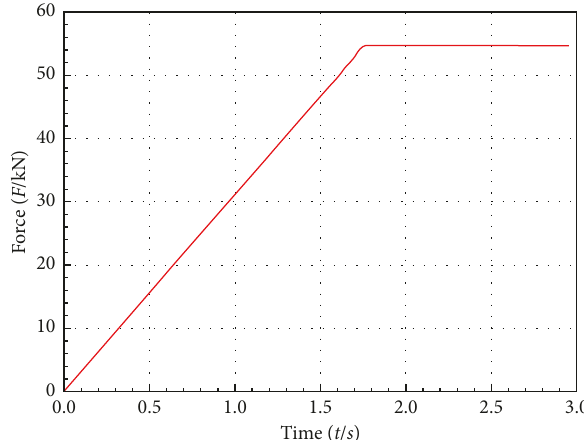
Figure 8: Cosimulation result of spring energy from